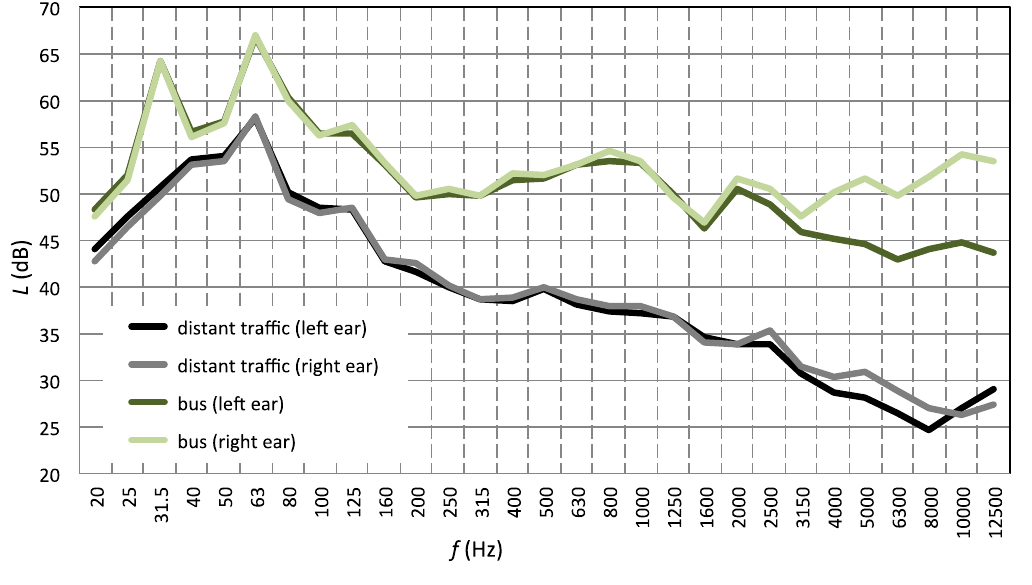
Figure 2. One third of an octave spectrum of distant traffic noise (as measured for left and right ear channel) and a passing bus (as measured for left and right ear